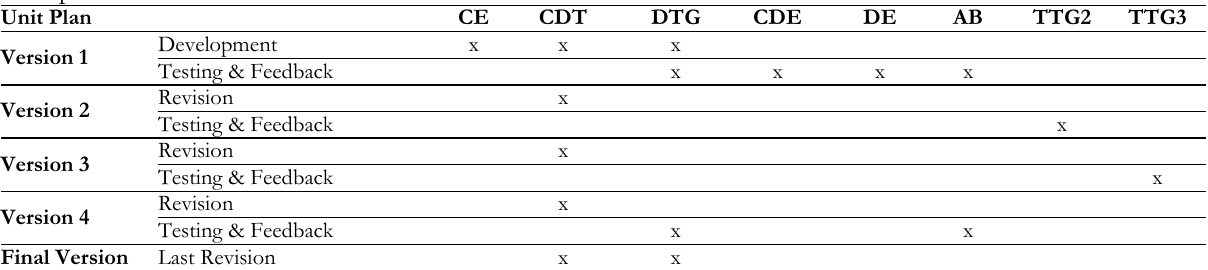
Table 1. Final iterative participatory development process for each unit in the curriculum. Key: CE = Content Experts; CDT = Curriculum Development Team; DTG = Developer Teacher Group; CDE = Child